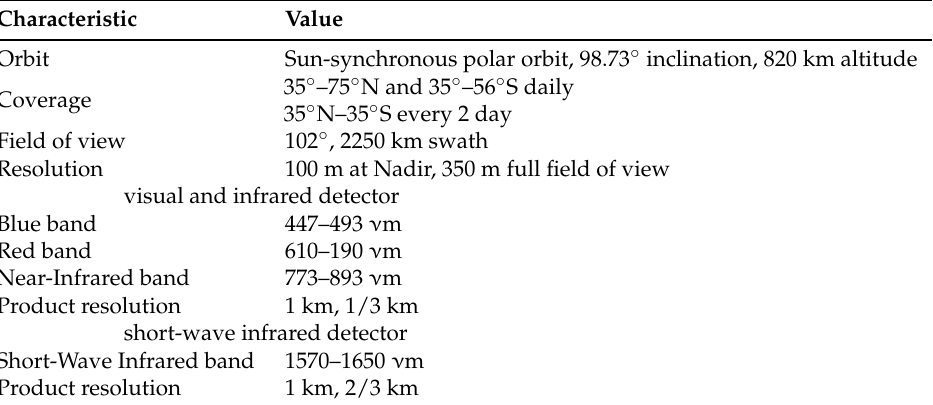
Table 1. Technical characteristics of PROBA-V sensor.